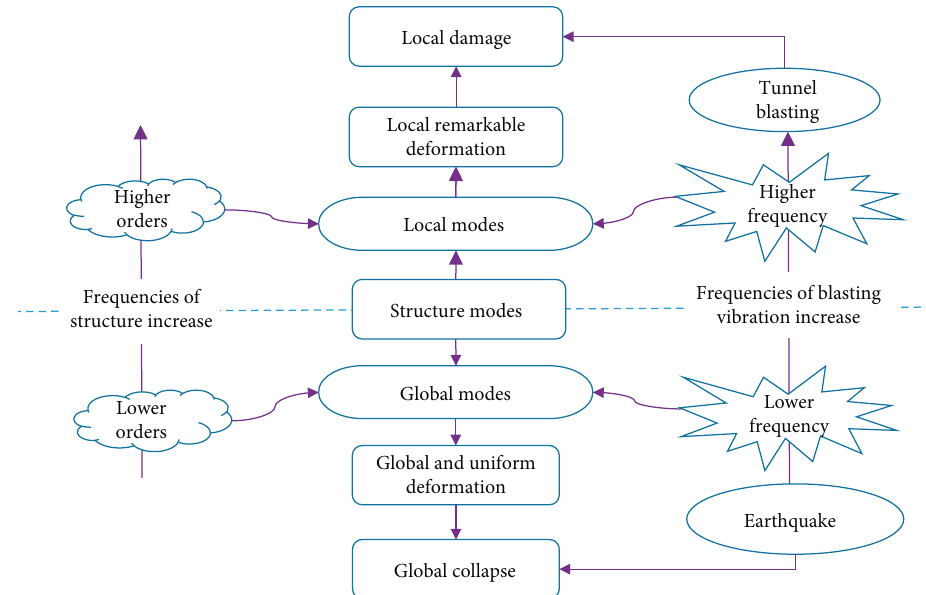
Figure 18: The interaction between external ground motion and structure modes.